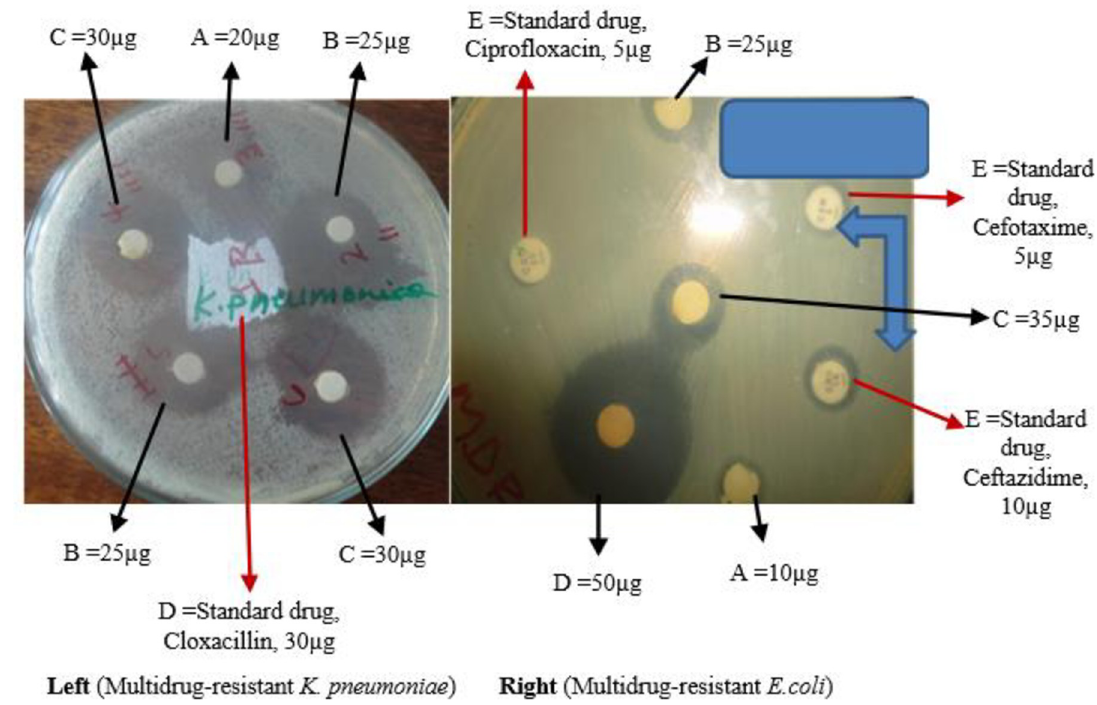
Fig 2. Antibacterial effect of Cirsium englerianum on MDR K . pneumoniae and E . coli .